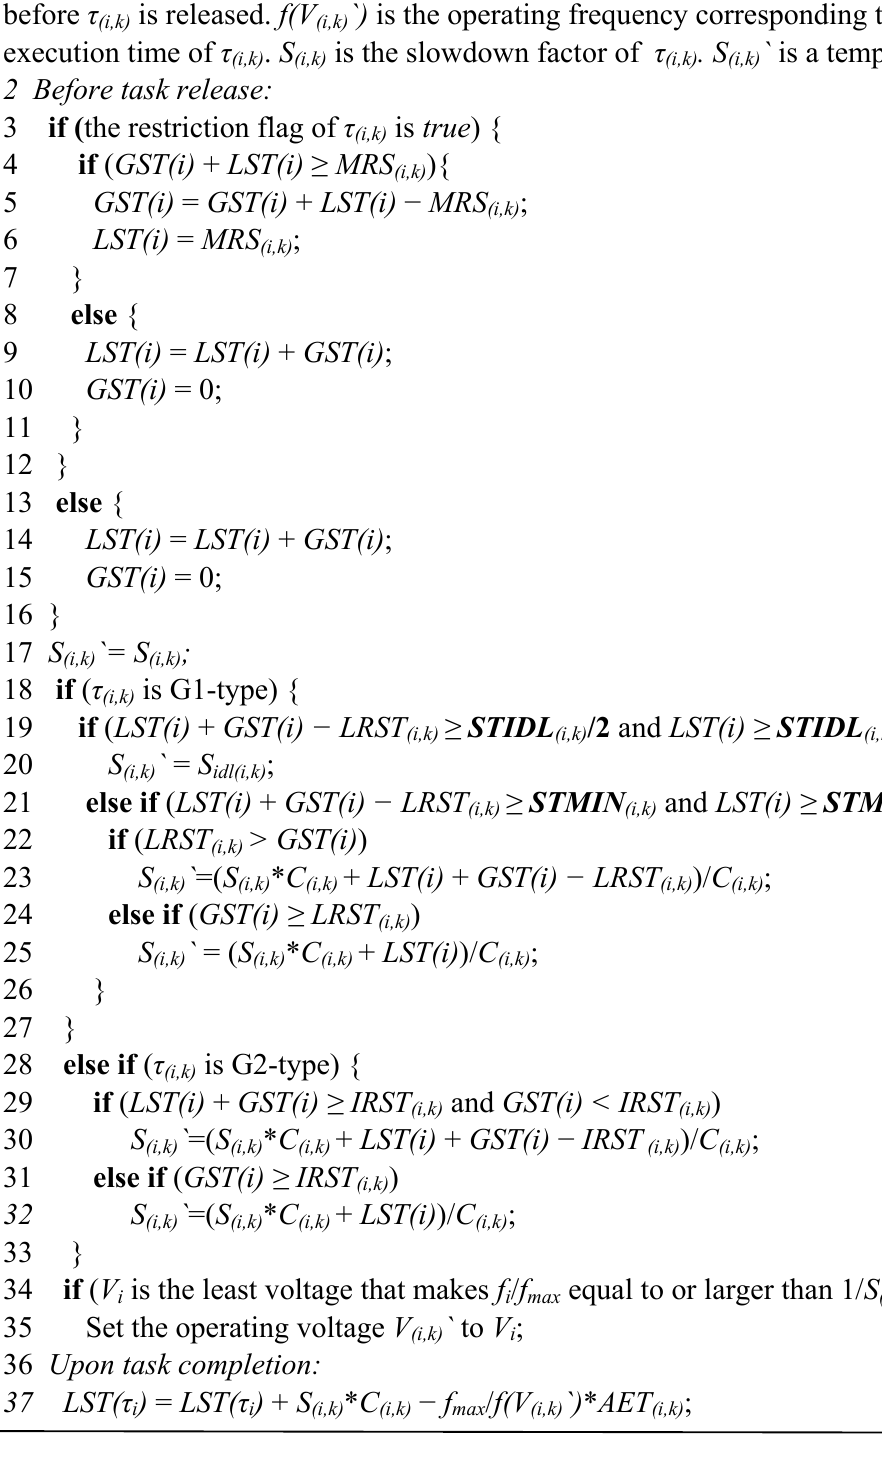
1 Algorithm HTDVS-SRT